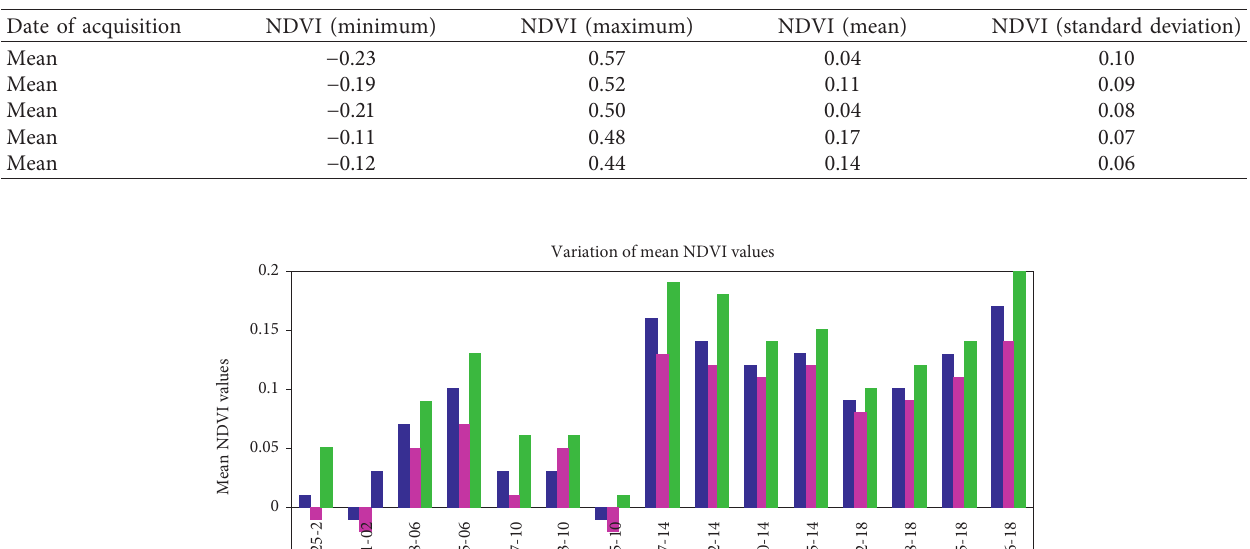
Table 7: Temporal variations of NDVI in the area below mean LST (2002–2018).